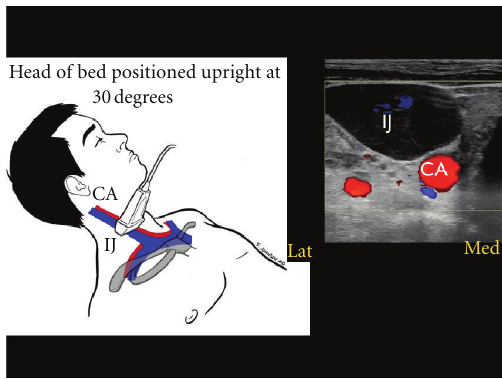
Figure 14: Inferior vena cava plethora, long axis view.